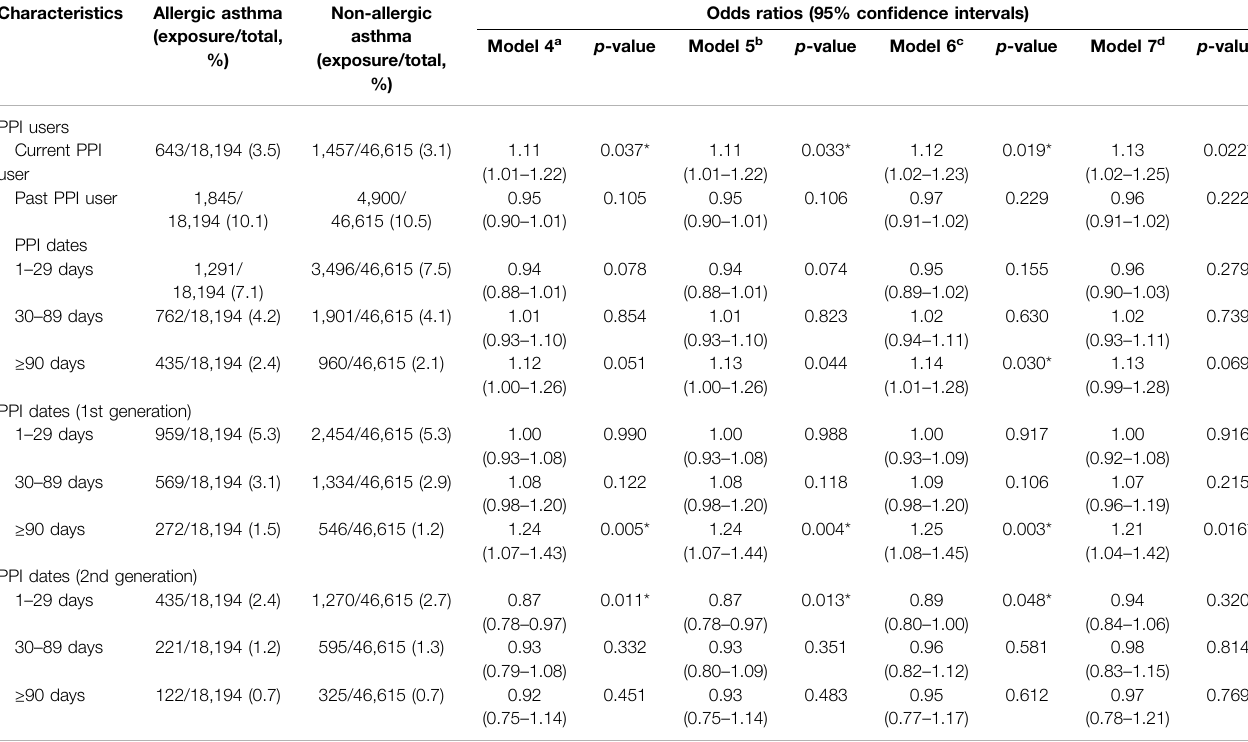
FIGURE 2 | Odds ratios (95% con fi dence intervals) of PPI prescription history/PPI prescription dates/prescription dates of each generation of PPI for asthma TABLE3| Oddsratios(95%con fi denceintervals)ofPPIprescriptionhistory/PPIprescriptiondates/prescriptiondatesofeachgenerationofPPIforallergicasthmainasthma patients. Characteristics